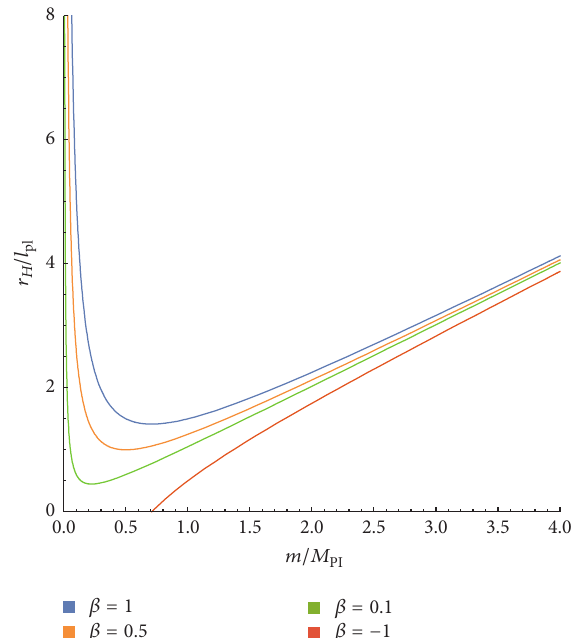
Figure 1: Horizon radius (22) as a function of mass 𝑀/𝑀 Pl for 𝛽 = 1 (blue, top), 𝛽 = 0.5 (orange, second from top), 𝛽 = 0.1 (green, third from top), and 𝛽 = −1 (red, bottom). In the last case, the horizon vanisheswhen 𝑀 = √|𝛽|/2𝑀 Pl andisdefinedonlyforbiggermasses than this cut-off. This Figure is reproduced from